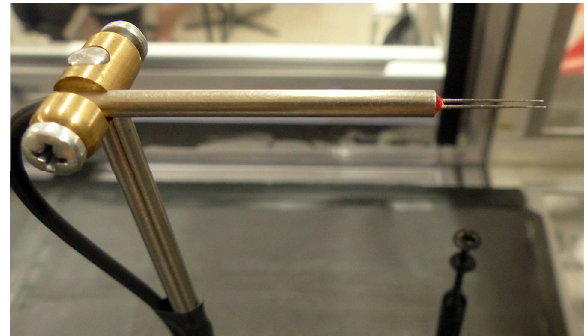
Fig. 3. The SWHWA under investigation. Picture taken during the calibration procedure. The head of the Schmidt type anemometer visible in the bottom right corner.